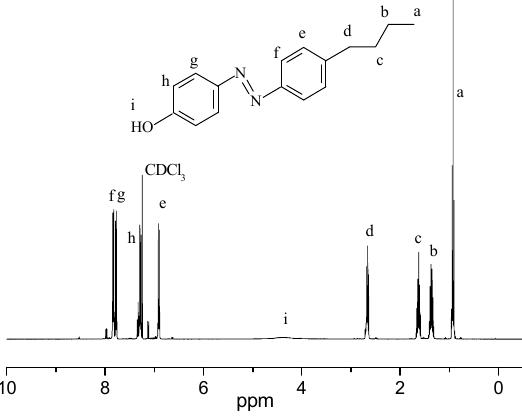
Figure 1. 1 H NMR spectrum of compound 1 in CDCl 3 .